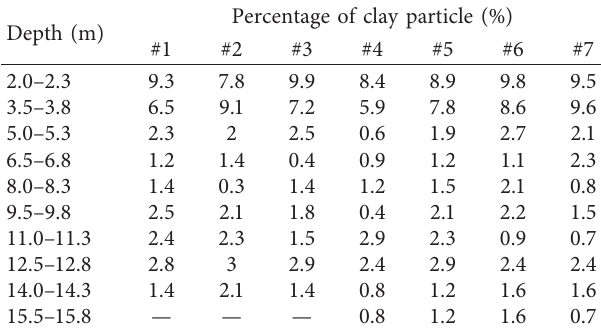
0 in SPT for classification of liq-